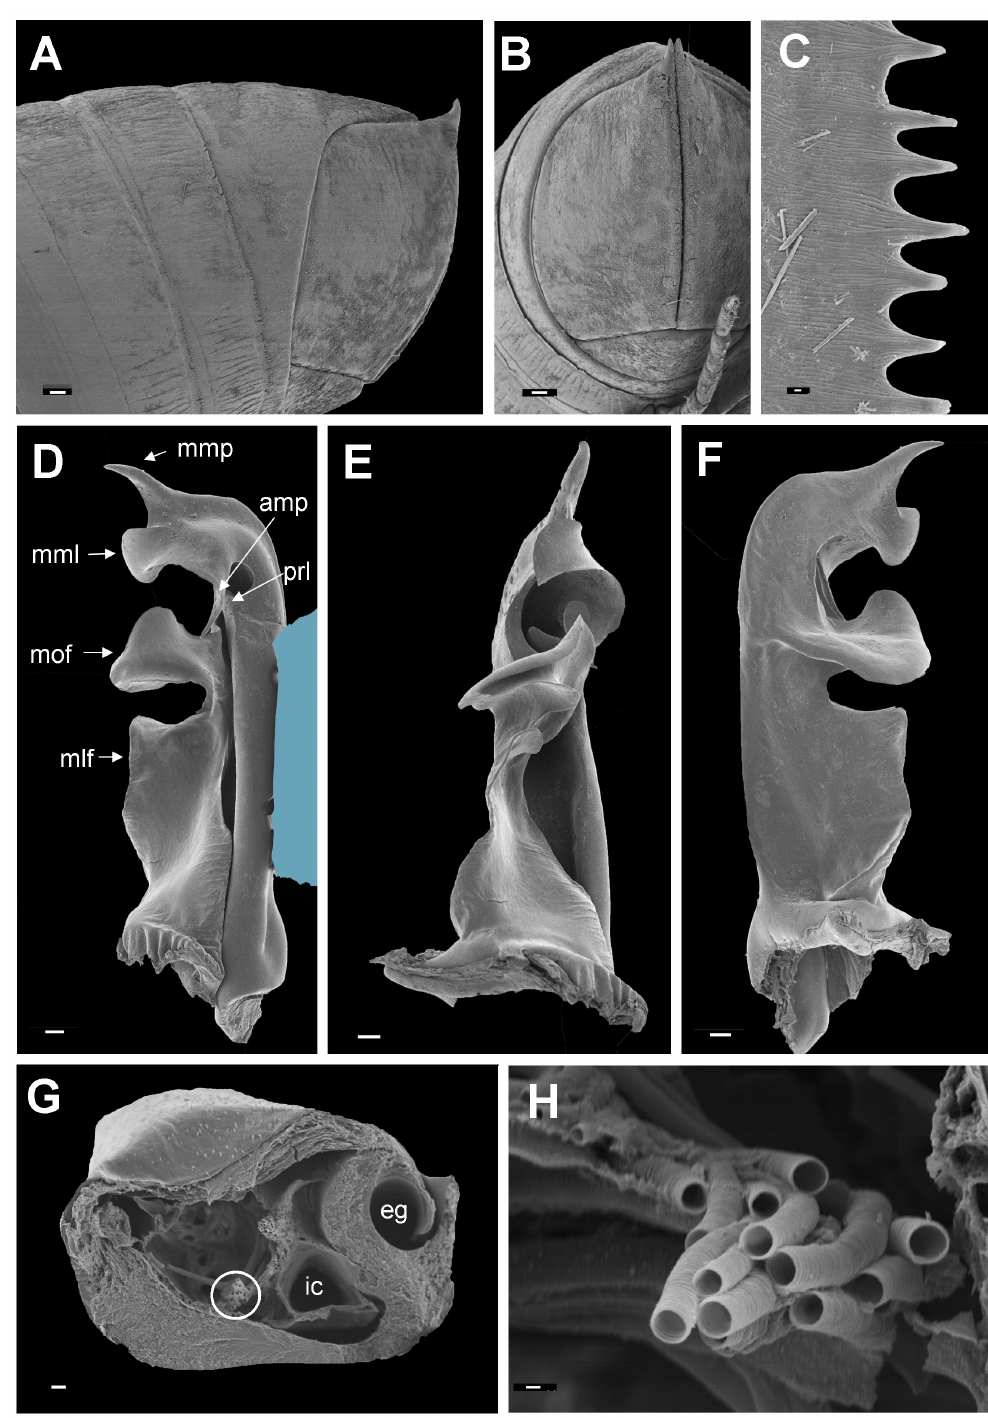
Fig. 3. Prionopetalum asperginis sp. nov., paratype from Kihansi, “forest site”. A – B . Hind end. A. Lateral view. B. Posterior view. C . Limbus. D – F . Right gonopod coxa. D. Anterior view (light blue: mounting tape). E. Mesal view. F. Posterior view. G . Transverse section of right gonopod basomere (circle: bundle of tracheae). H . Cluster of tracheae next to internal canal. Abbreviations: amp = anterior metaplical process; eg = efferent groove; ic = internal canal; mlf = metaplical longitudinal flange; mml = metaplical mesad lobe; mmp = distomesal metaplical process; mof = metaplical oblique/horizontal flange; prl = proplical lobe. Scale bars: A, B, D–F = 0.1 mm; C, H = 0.001 mm; G = 0.01